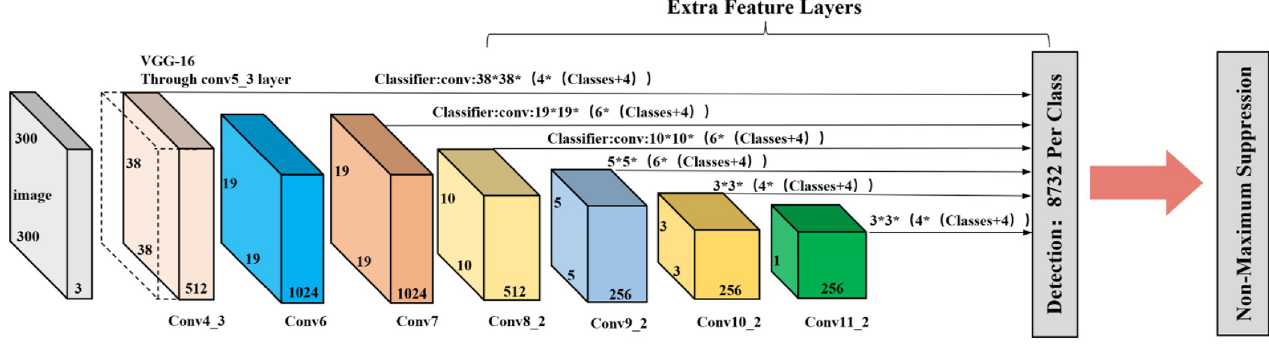
Fig 1. Structure of